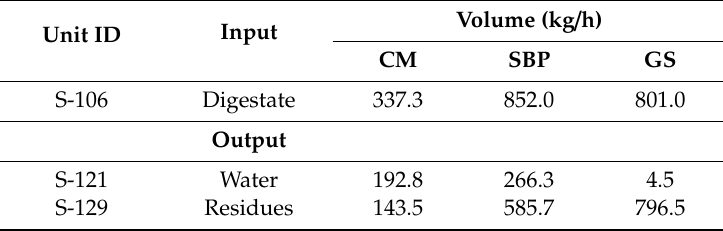
Table 8. Input and output from the digestate processing stage.